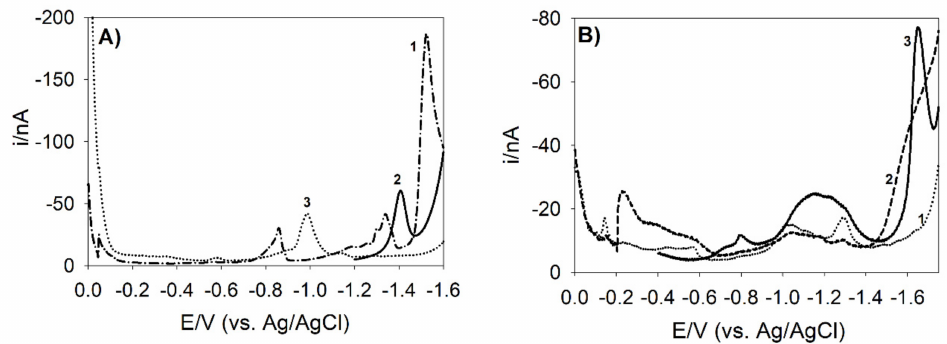
Figure 4. SW voltammograms of standards ( A ) (1) Co(II)-Phen-PC with c PC = 1 × 10 − 5 mol dm − 3